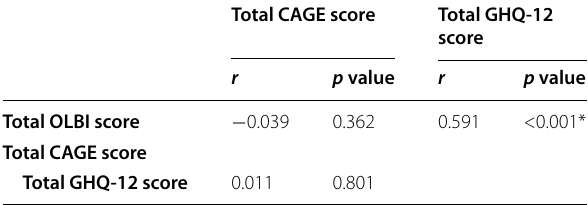
r Pearson correlation coefficient; * p statistically